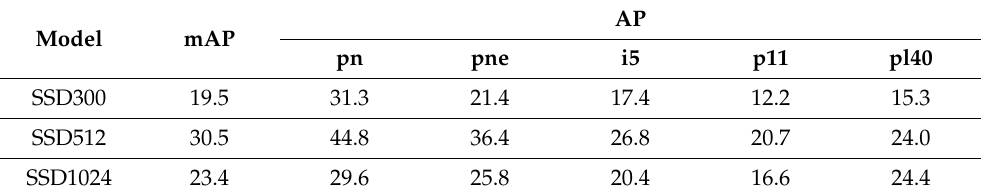
Table 1. Results of various SSD architectures on the small object